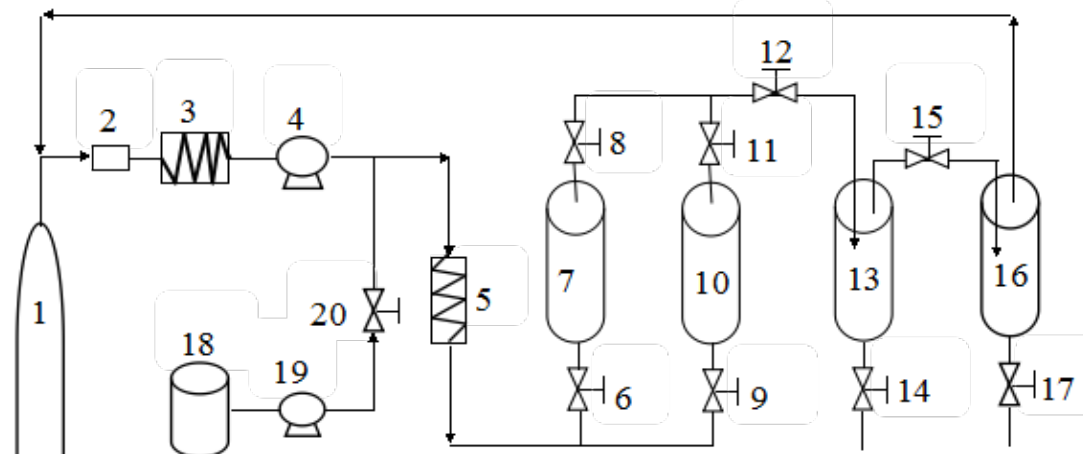
Figure 2. Scheme of supercritical carbon dioxide extraction equipment. 1. CO 2 cylinder. 2. Filter. 3.